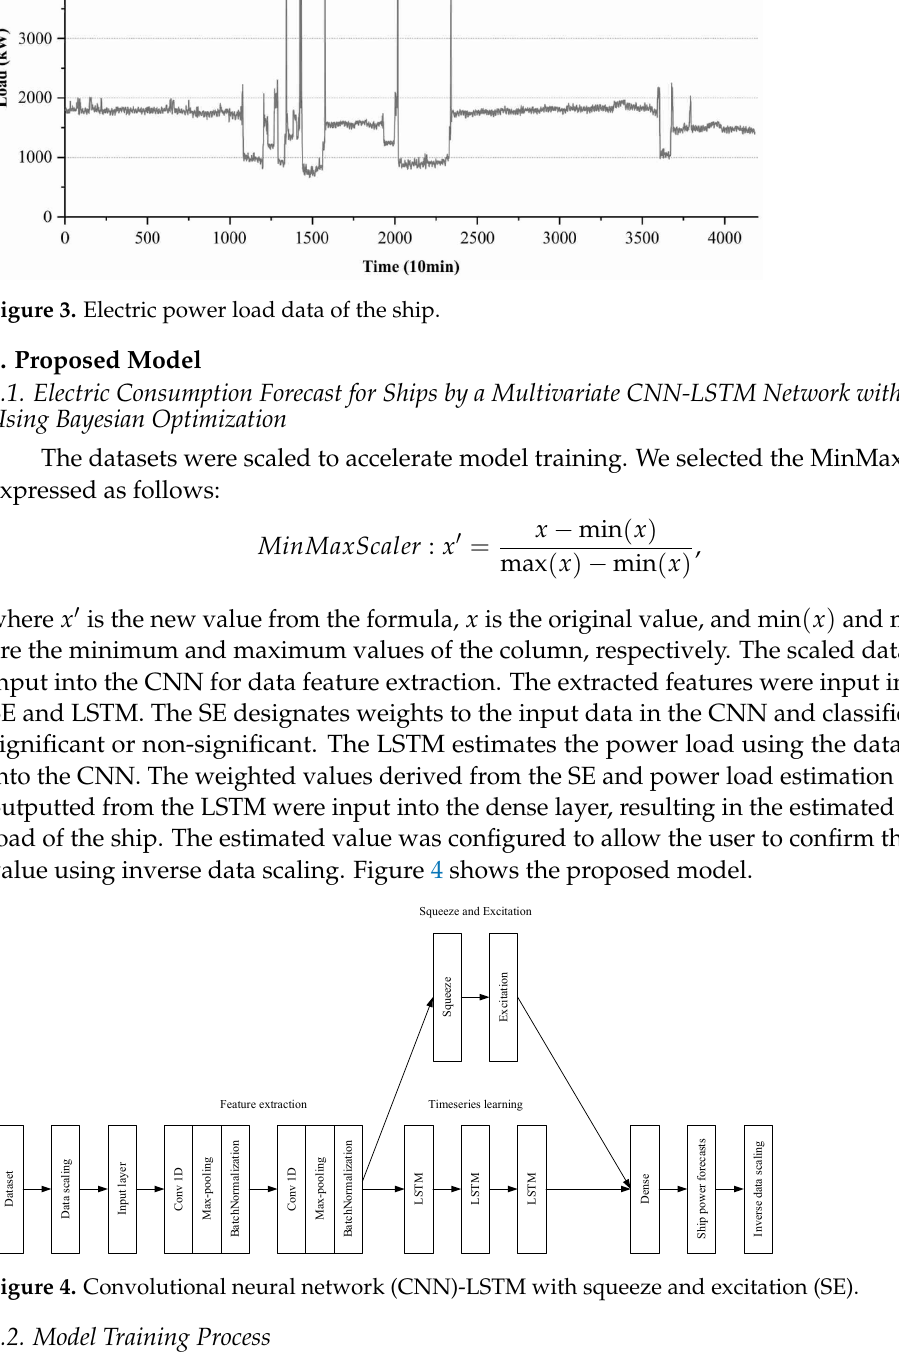
Figure 4. Convolutional neural network (CNN)-LSTM with squeeze and excitation (SE).